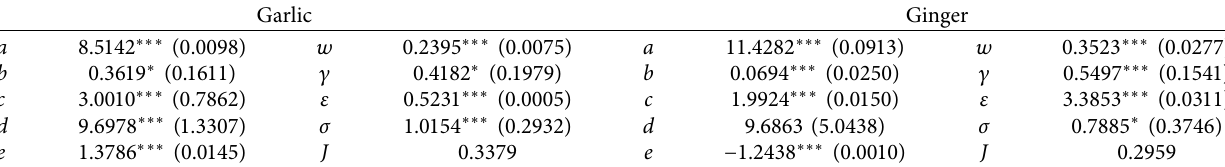
Table 1: SMM estimated parameters for garlic and ginger.